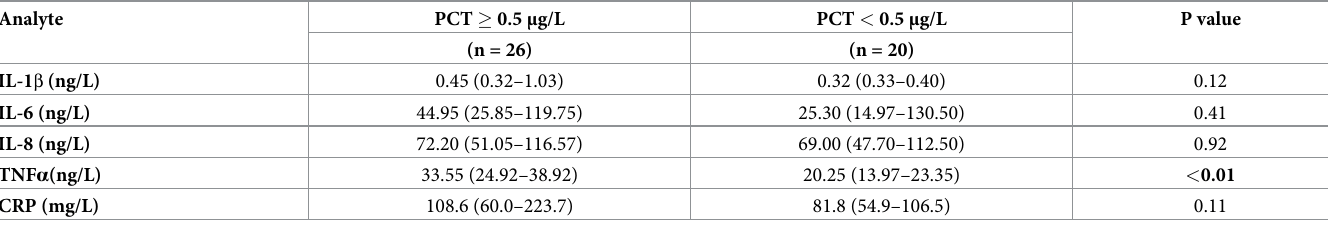
Table 4. Cytokines and CRP in ICU patients with high and normal